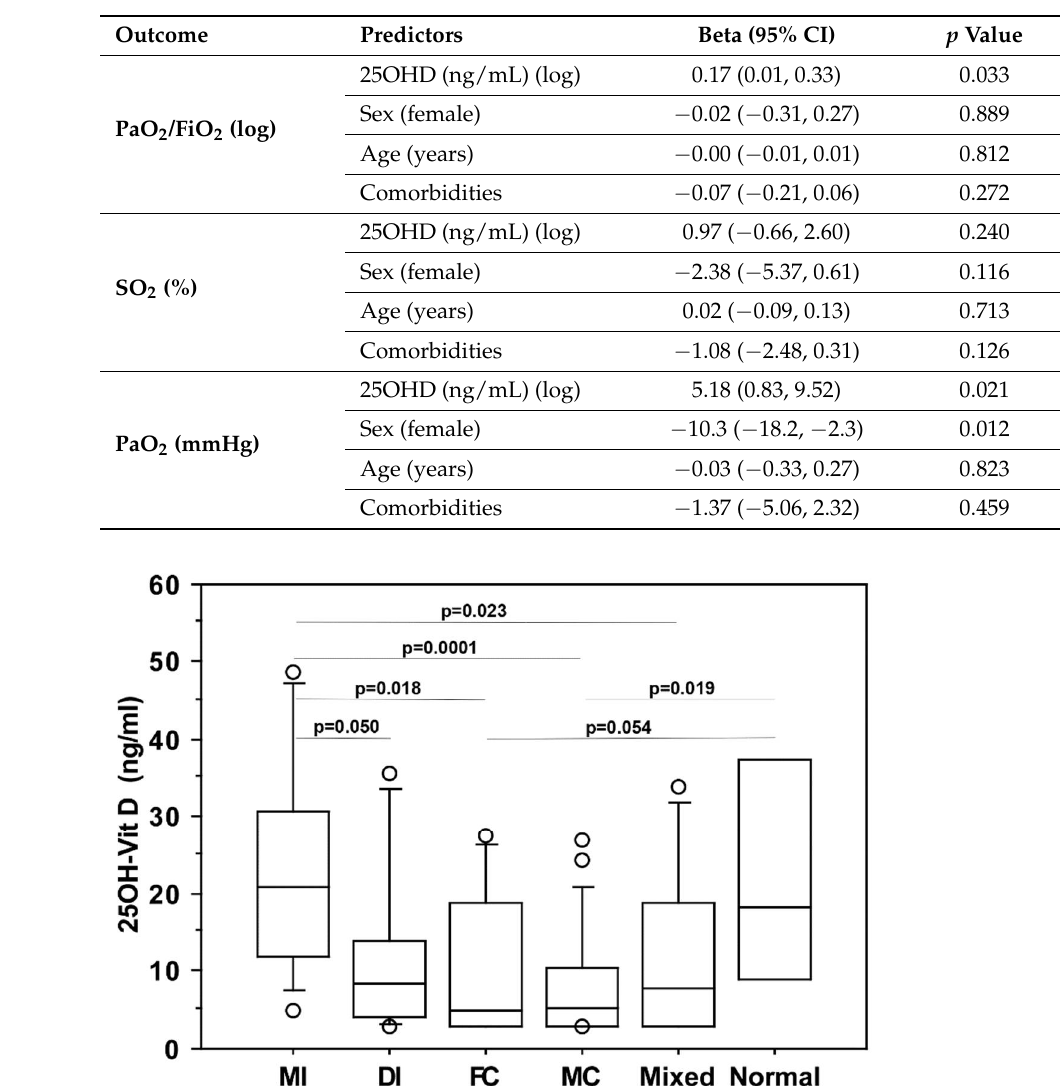
Table 4. Multiple linear regression results showing the statistically significant associations between vitamin D serum levels (25OHD) and both PaO 2 /FiO 2 ratio and PaO 2 .